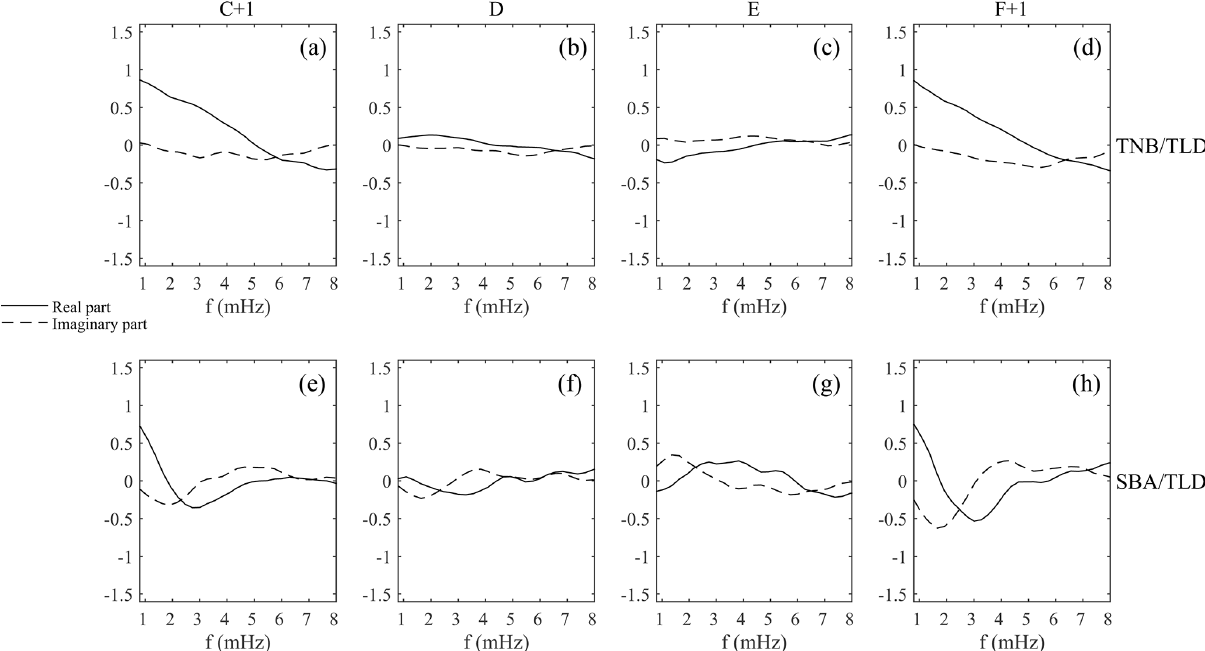
Figure 8. Horizontal transfer functions from interstation method at TNB (a, b, c, d) and SBA (e, f, g, h) ; solid and dotted lines indicate the real and imaginary parts,